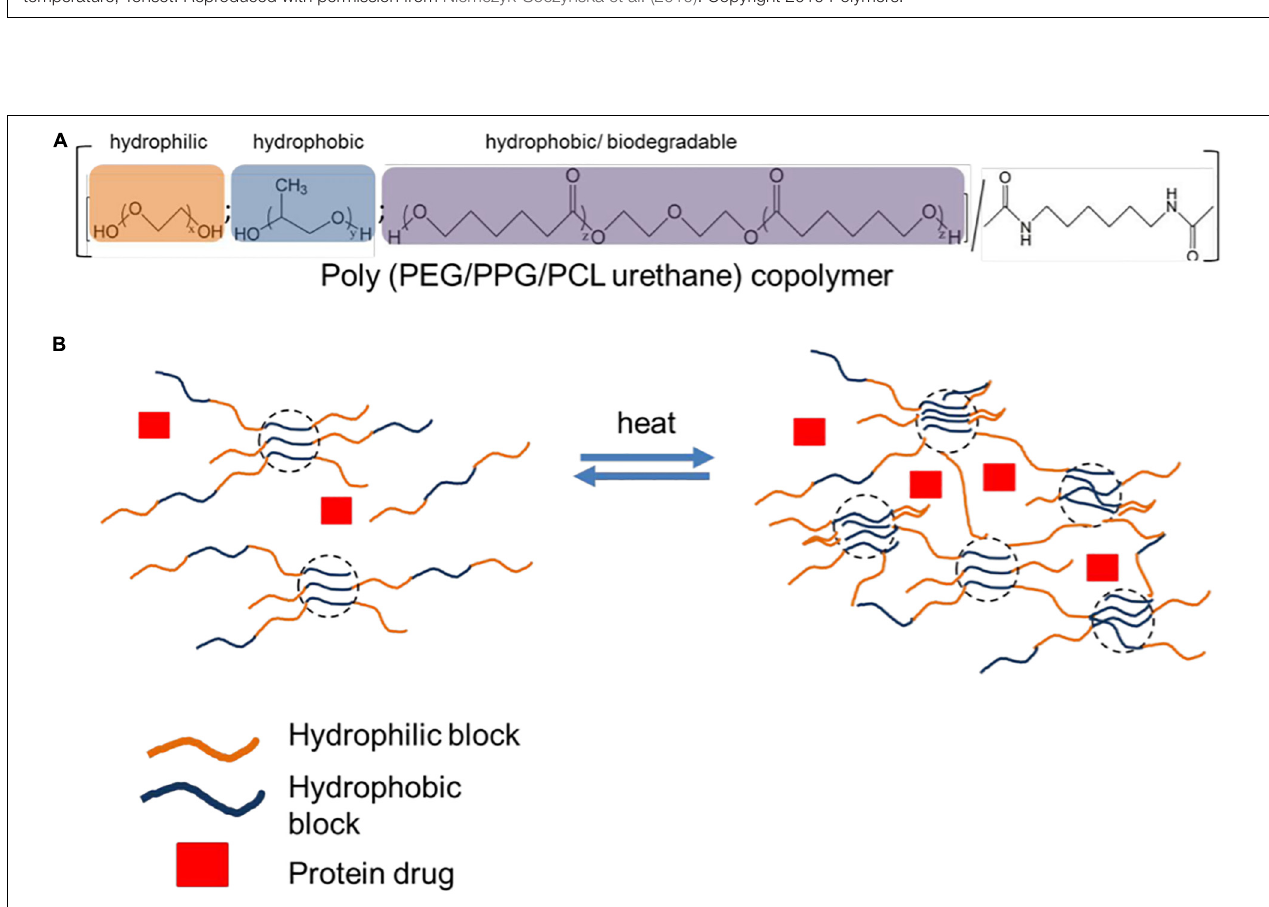
FIGURE 8 | The rates, k, of water cages formation (exo), their destruction (endo 1), and of crosslinking (endo 2), as a function of – (A) the MC content and (B ) the temperature, Tonset. Reproduced with permission from Niemczyk-Soczynska et al. (2019). Copyright 2019 Polymers.